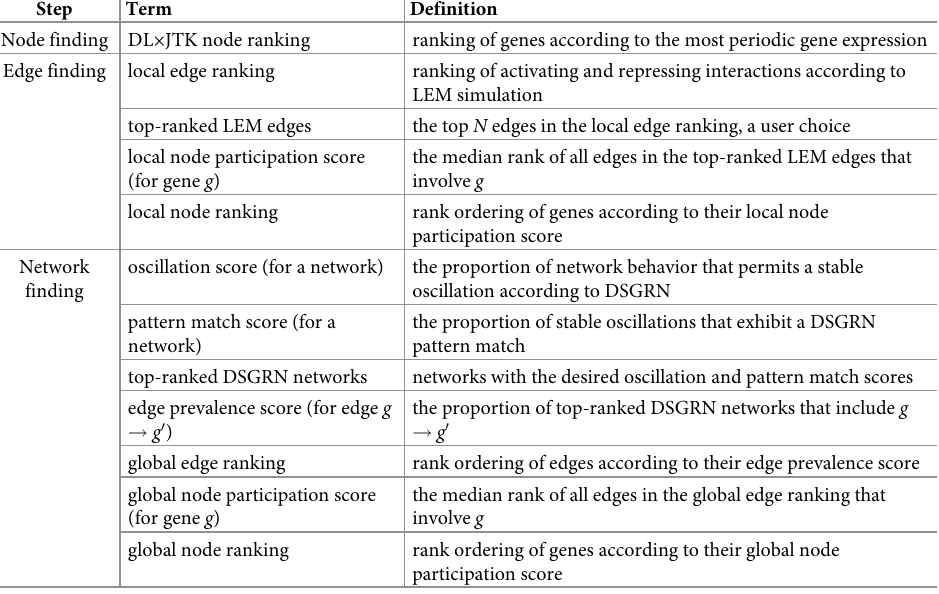
Table 1. Metrics table: Key terminology for scoring and ranking nodes, edges, and networks in the Inherent dynamics pipeline in order of computation. Step Term Definition Node finding DL × JTK node ranking ranking of genes according to the most periodic gene expression Edge finding local edge ranking ranking of activating and repressing interactions according to LEM simulation top-ranked LEM edges the top N edges in the local edge ranking, a user choice local node participation score the median rank of all edges in the top-ranked LEM edges that (for gene g ) involve g local node ranking rank ordering of genes according to their local node participation score Network oscillation score (for a network) the proportion of network behavior that permits a stable finding oscillation according to DSGRN pattern match score (for a the proportion of stable oscillations that exhibit a DSGRN network) pattern match top-ranked DSGRN networks networks with the desired oscillation and pattern match scores edge prevalence score (for edge g the proportion of top-ranked DSGRN networks that include g ! g 0 ) ! g 0 global edge ranking rank ordering of edges according to their edge prevalence score global node participation score the median rank of all edges in the global edge ranking that (for gene g ) involve g global node ranking rank ordering of genes according to their global node participation